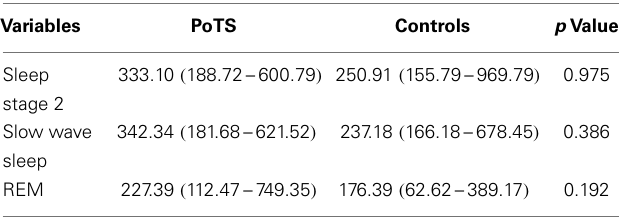
Table 4 | HF band power (ms 2 /s) across different sleep stages in median with its interquartile range .